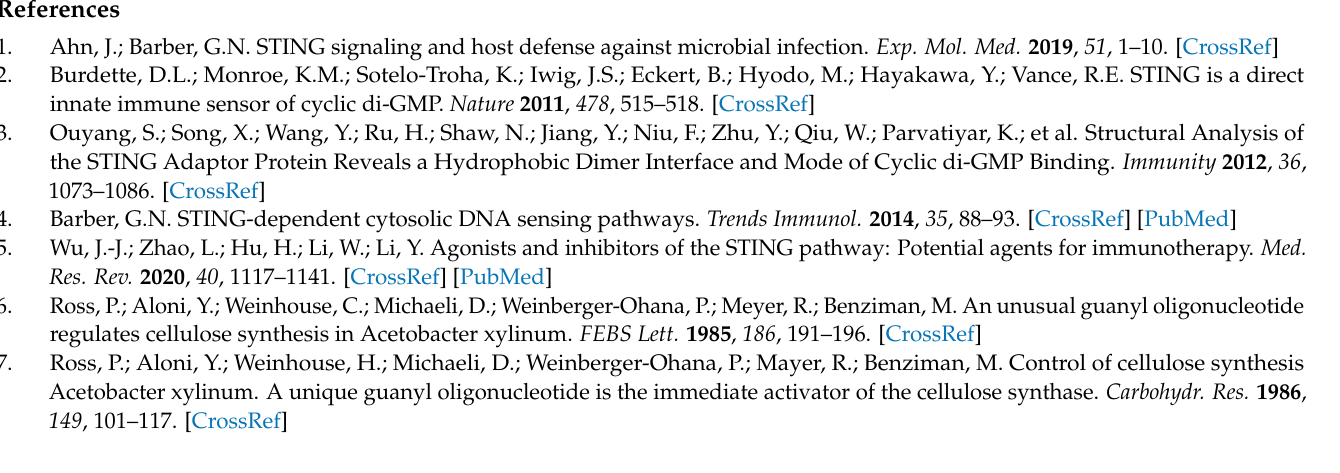
Figure S3: Selected CDN analogs with internucleotide linkages that are not phosphorous based, and Figure S4: c-di-GMP conjugates